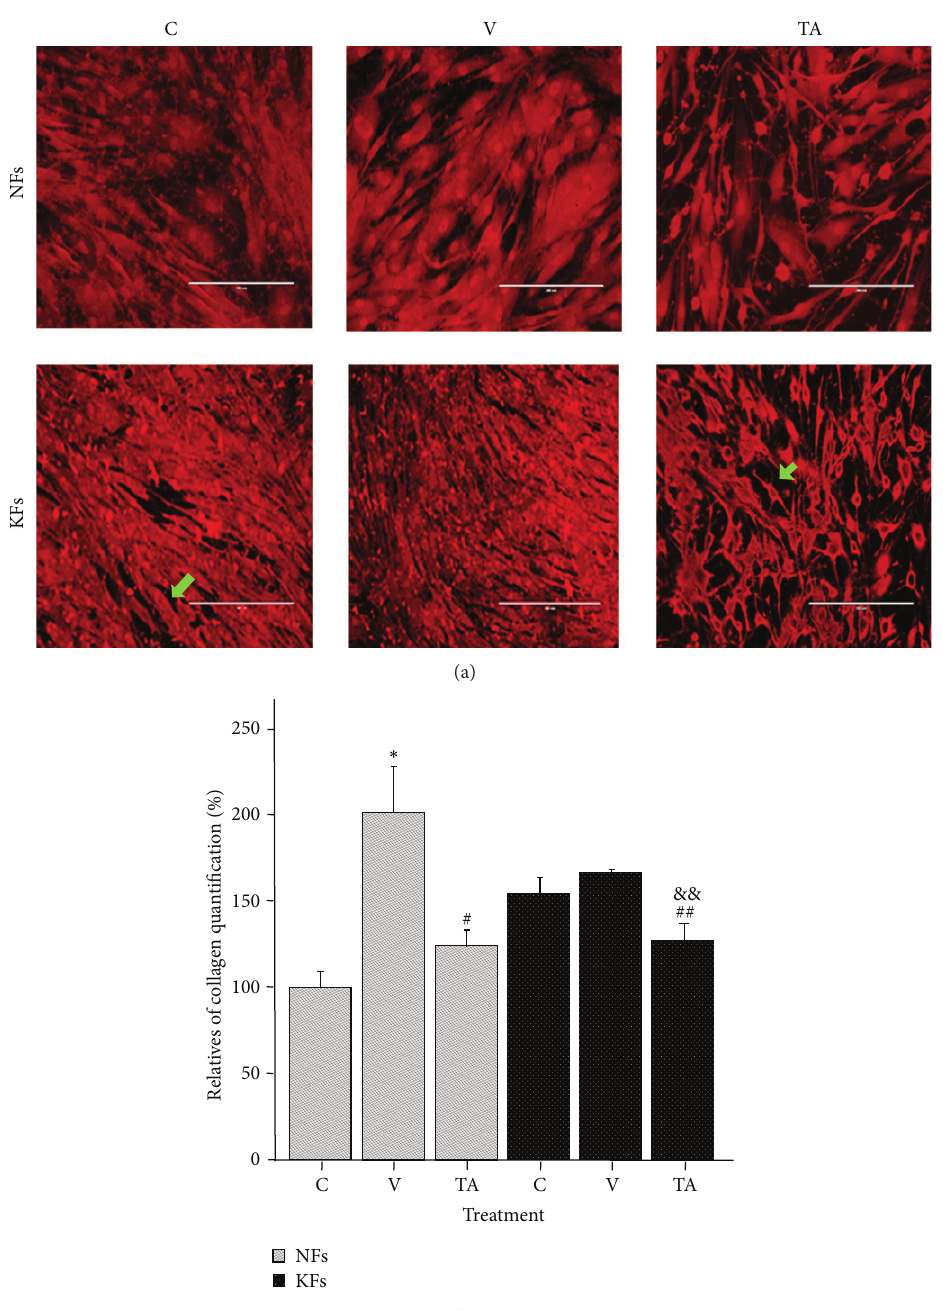
Figure 4: The effect of TA on collagen production in NF and KF after Sirius red staining. DMSO significantly increased collagen production in NFs. TA strikingly reduced collagen production in KFs compared with NFs. C: control, total medium; V: vehicle, 0.55% DMSO; TA, 0.55 × 10 −3 M of TA was dissolved in 0.55% DMSO. ∗ 𝑃 < 0.01 , V versus C; # 𝑃 < 0.05 , TA versus V; ## 𝑃 < 0.05 , TA versus C; && 𝑃 < 0.01 , TA versus V; 𝑛 = 4